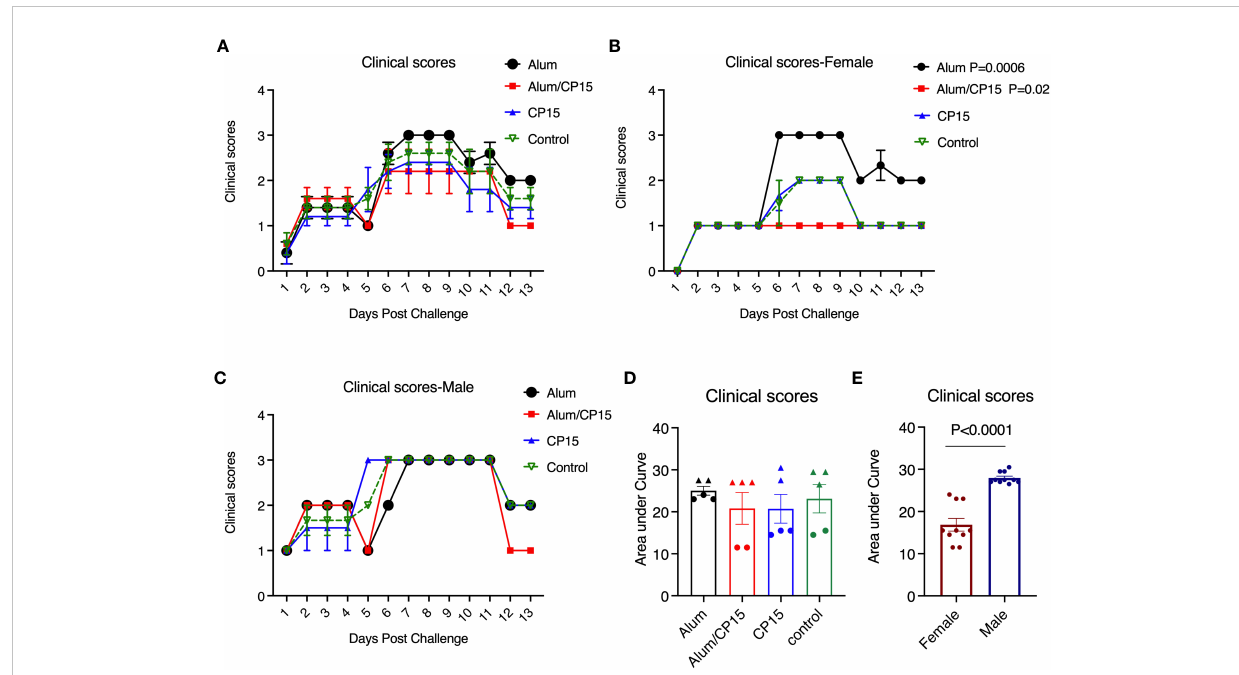
FIGURE 4 Clinical scores of the hamsters after SARS-CoV-2 Washington strain challenge. (A – C) . After SARS-CoV-2 Washington strain infection, animals were monitored, and clinical scores were given each day. The clinical score was based on the observation whether ruf fl ed fur and/or hunched back was present in the animals: milder ruf fl ed fur =1; ruf fl ed fur= 2, and hunched back=1, and if none of them was present the animal will be given a score of zero. The clinical score was calculated based the sum of ruf fl ed fur and hunched back scores. Kinetics of clinical score changes in all the animals (A) , females (B) , and males (C) of difference groups. (D, E) . Comparisons of area under curve of clinical score changes in females and males. N=5 for each group. The triangles denote males, and the dots denote females in (D) . Each dot represents one animal in (E) . Two-way ANOVA and Mann- Whitney analysis were used to compare between the vaccinated groups and the control group. Mean ± SEM are